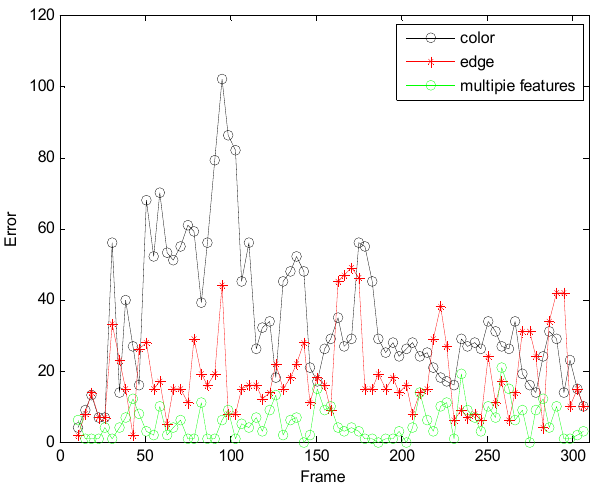
Figure 13. The RMSE comparison corresponding to background changes.